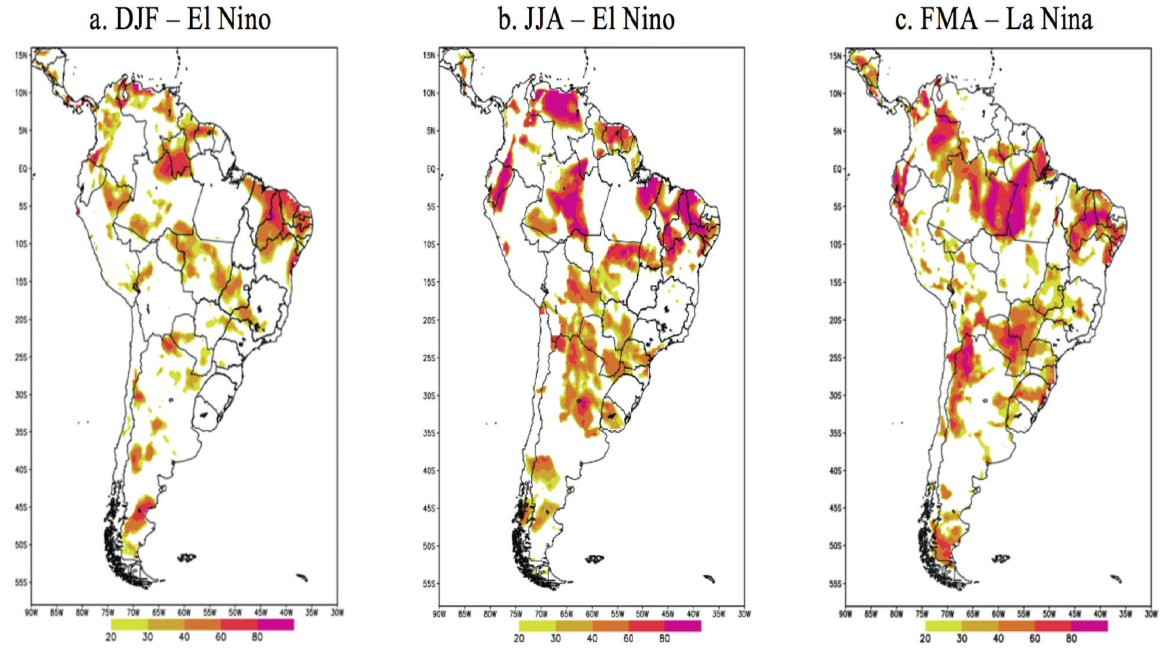
Figure 10. Skill scores of the seasonal precipitation anomaly (%) forecast by the Eta model with one-month lead time for DJF (a) and JJA (b) for El-Niño years; and (c) FMA of La Niña years. Only positive skill scores are